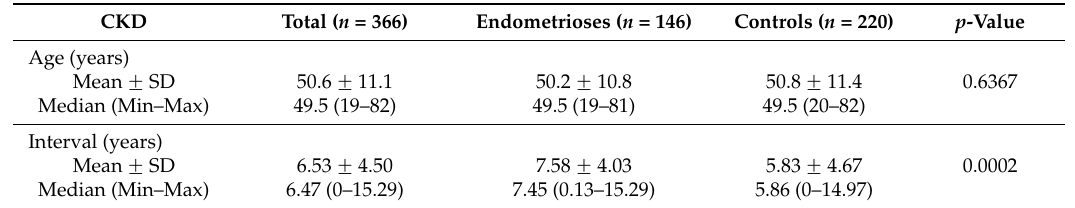
Table 5. Age and surveillance time between enrollment in the cohort and the diagnosis of chronic kidney